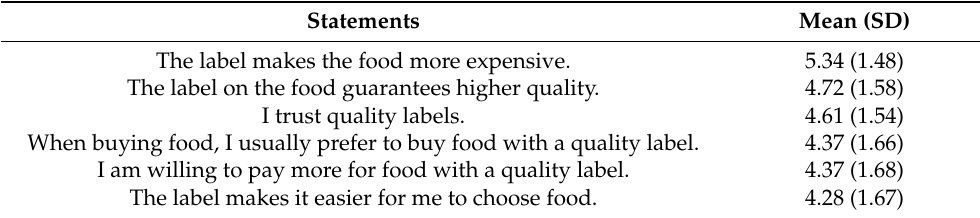
Table 2. Levels of Agreement with Statements Related to Food Labeling Schemes ( n = 1007).